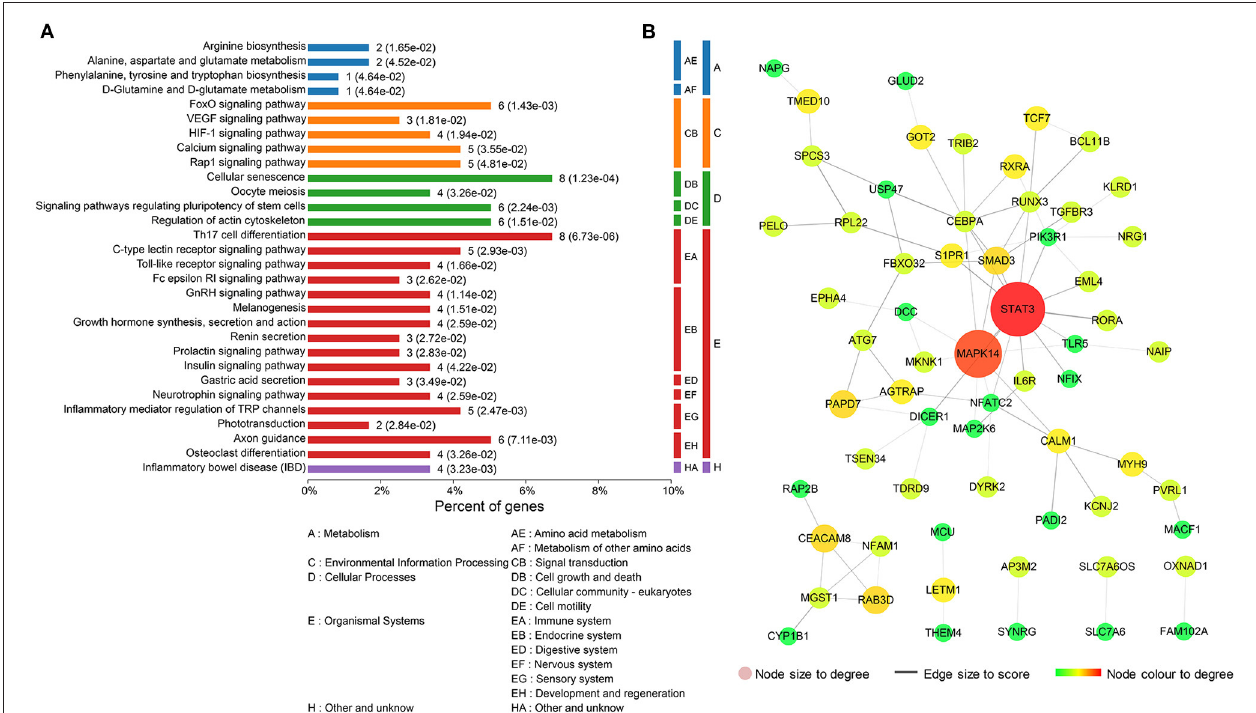
FIGURE 4 | Functional analysis of the 119 differentially expressed mRNAs (DEGs) that intersected with the target genes of differentially expressed miRNAs (DEMs). (A) Kyoto Encyclopedia of Genes and Genomes (KEGG) enrichment pathway analysis for the 119 intersected DEGs. (B) Protein–protein interaction (PPI) network for the 119 intersected